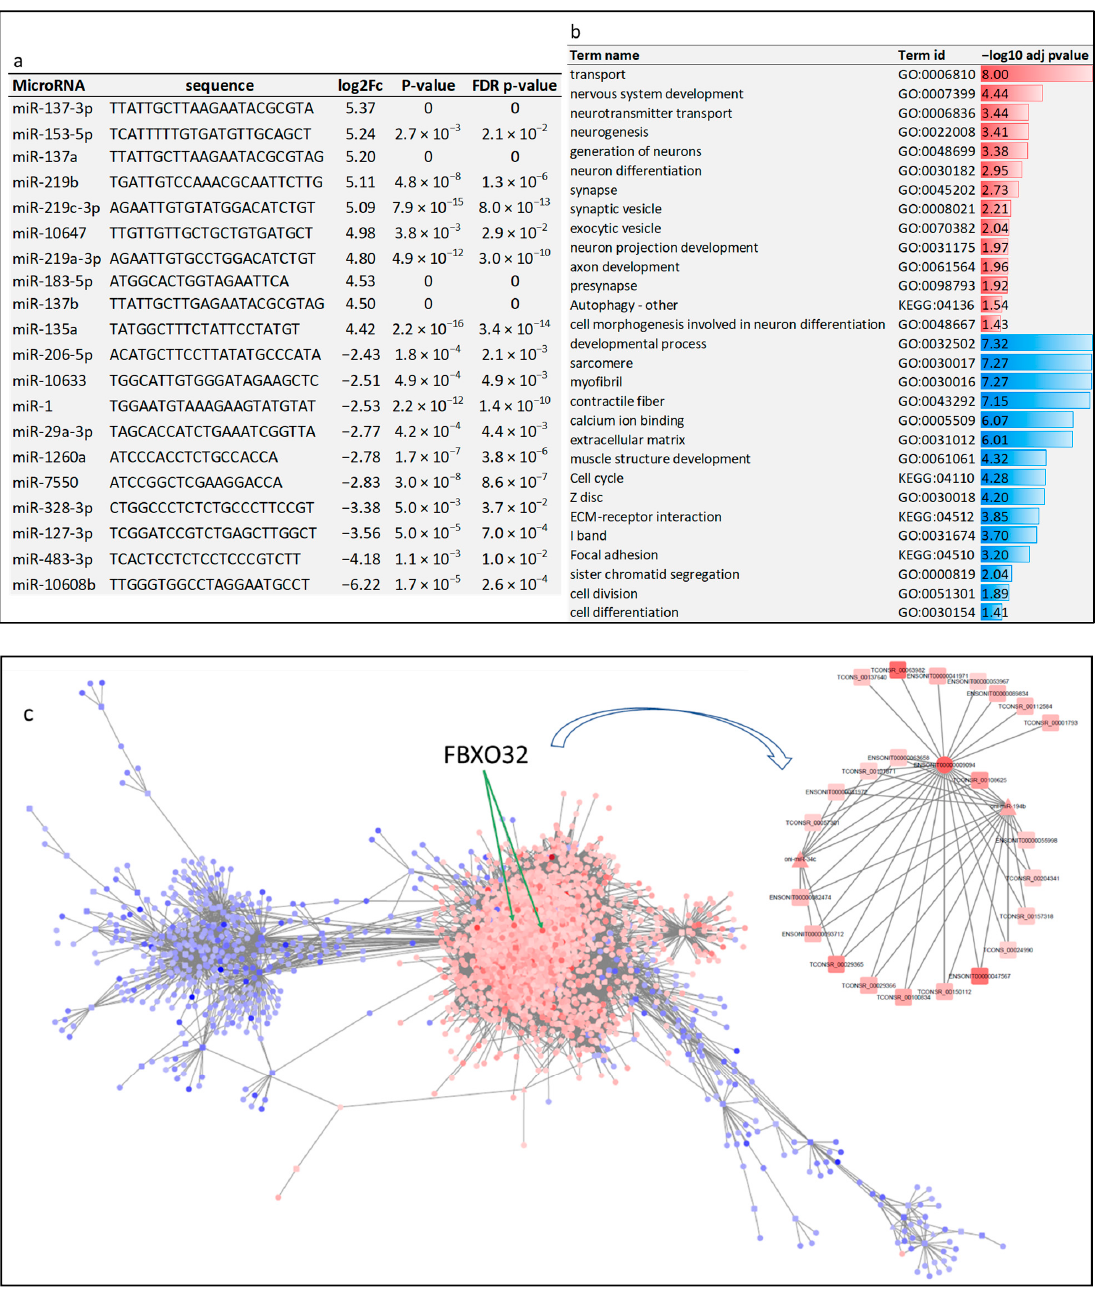
Figure 4. ( a ) A selected set of the most significantly differential microRNAs in atrophying muscle of starved versus fed fish. MicroRNA-137-3p was the most highly expressed, and miR-10608b was the most downregulated microRNA due to feed restriction. Several isoforms of miR-137 were upregulated in starved fish. Fold change was considered significant at cutoff value >2 or < − 2 and FDR p -value < 0.05. ( b ) Enrichment analysis of differential transcripts potentially targeted by differential microRNAs following starvation. Over-represented KEGG pathways and GO terms are represented in red, whereas under-represented KEGG pathways and GO terms are represented in blue. Negative log10 of adj p -values are plotted. ( c ) Gene expression network of differential mRNAs (circular nodes), lncRNAs (rectangular nodes), and microRNAs (triangular nodes) (R > 0.80 or < − 0.80). The red nodes represent upregulated transcripts in the starved fish (fold change > 4), whereas the blue nodes represent downregulated transcripts (fold change < − 4) at FDR ≤ 0.05. Most of the differential transcripts are clustered in two major networks. The large network (tilapia degradome)